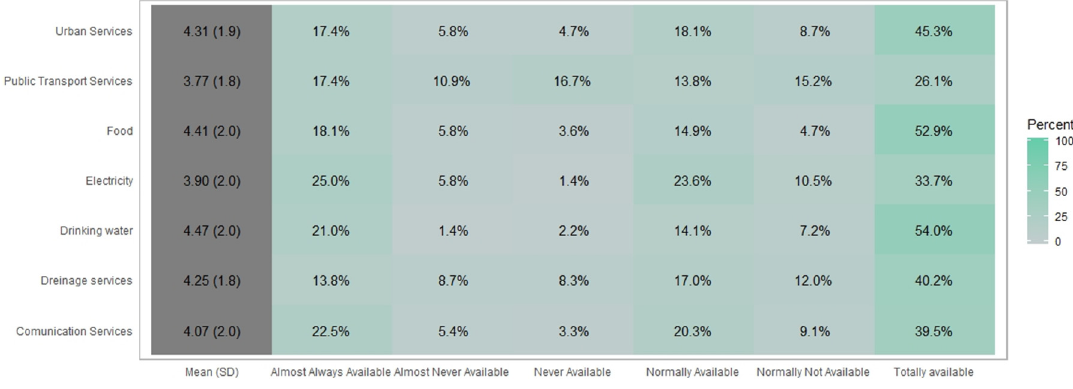
Figure 6. Graphic generated by percentage of perceived availability of drinking water, food, urban services, drainage services, communication services, electricity and public transport services before a flood occurs and, if necessary, after it has occurred.